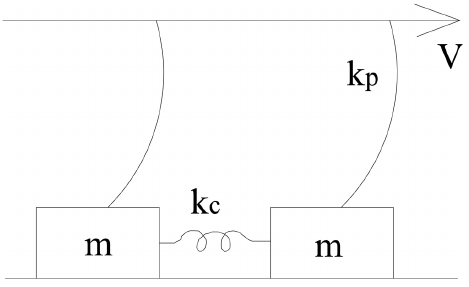
Fig. 1. Burridge–Knopoff model with two blocks. Parameter m rep- resents the mass of the block, k c and k p are the spring constants, and V denotes the velocity of the driving